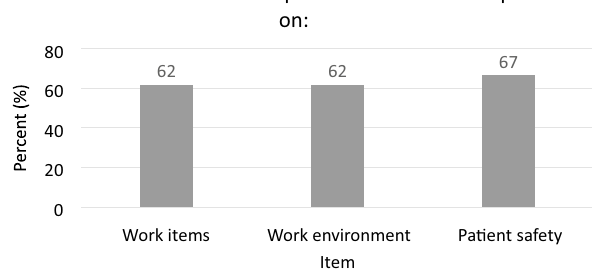
Figure 3. Staff perception of ultraviolet disinfection impact of work-related